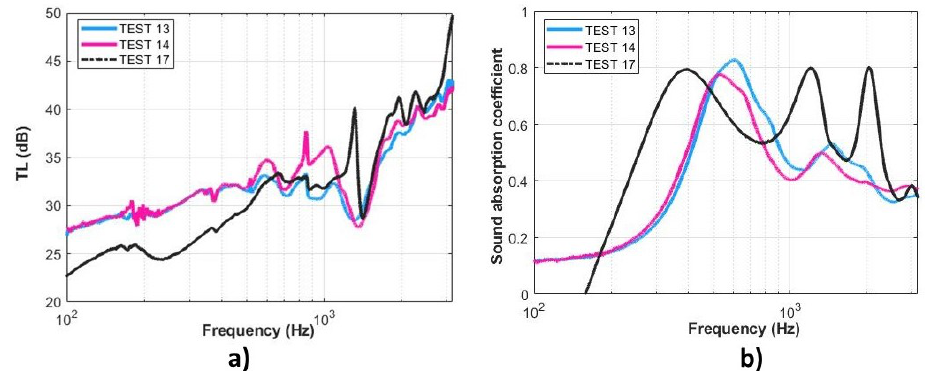
Figure 11. Transmission loss ( a ) and absorption coefficient ( b ) of samples made of several layers of cardboard.